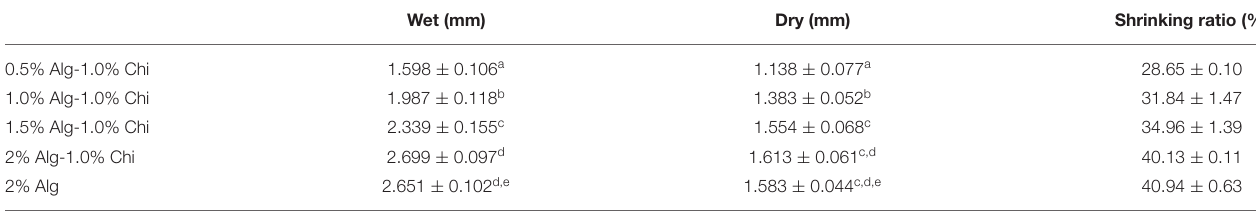
TABLE 1 | The mean sizes and the shrinking ratio of Alg-Chi hydrogel beads were determined by ZEN2012 Blue software. Wet